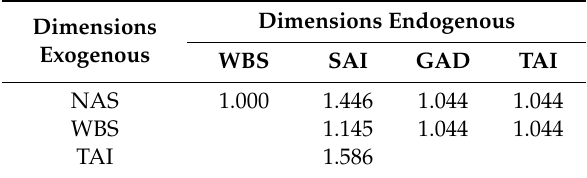
Table 10. Values of VIF for the dimensions PANAS-GAD-7-IDATE model. Dimensions